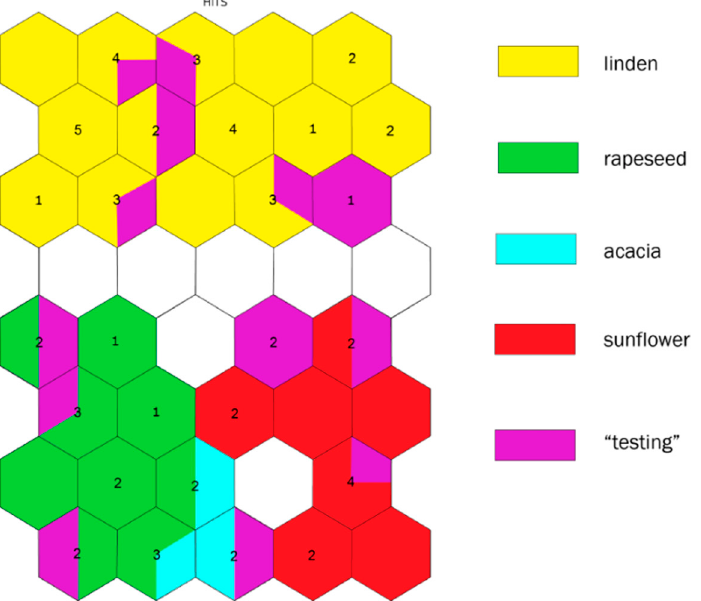
Figure 4. The HIT diagram of training and testing group of honey samples with the set of de- scriptors.